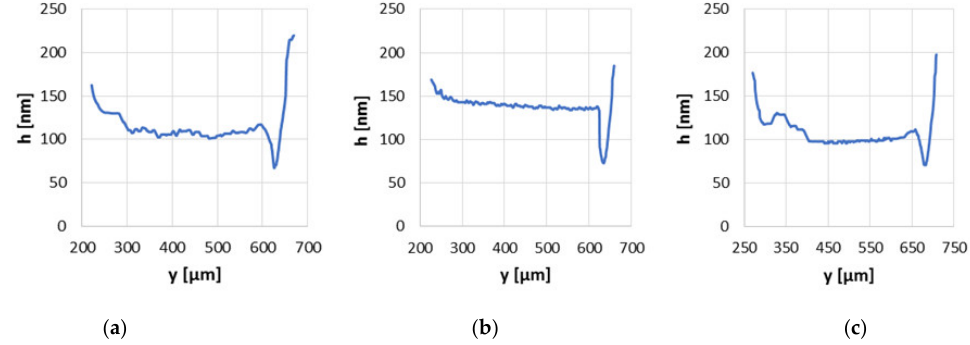
Figure 11. Oil film thickness distribution graphs in non-conformal contact with load of 30 N and sliding velocity of 0.1 m/s for the base surface ( a ), modified surfaces no. 2 ( b ) and no. 3 ( c ).